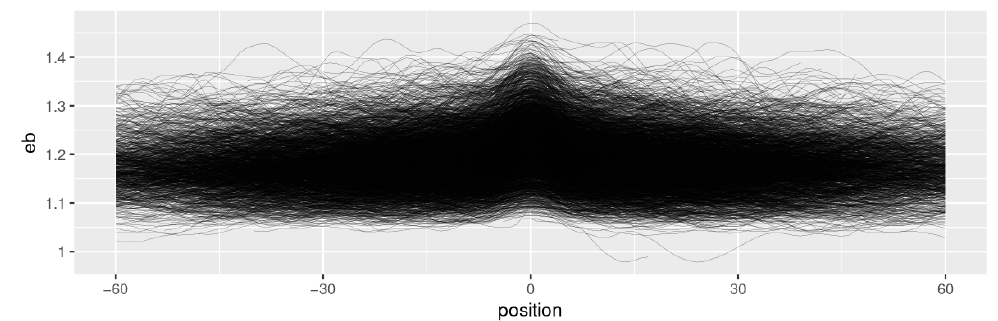
Figure A1. Time series for eyebrow movement around the peak of a segment (complete sample). The values are scaled per segment.